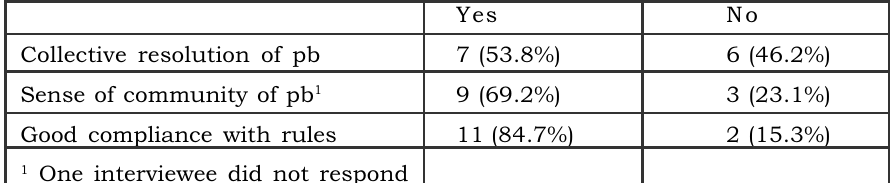
Table 2 Community cohesion (nb and % of respondents) Thabina